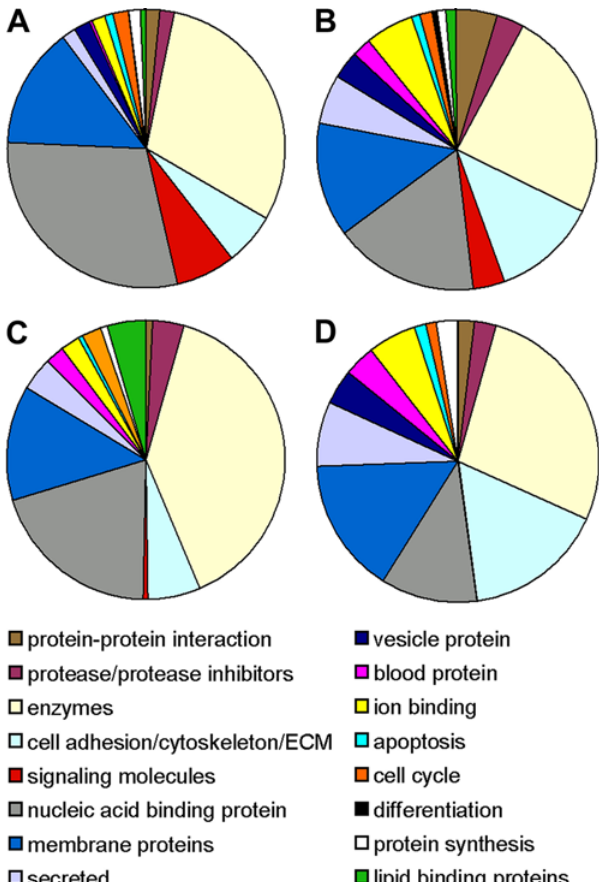
Figure 4. Relative proportion of transcripts altered in Hnf6 Tg animals as determined by gene ontology analysis. Known transcripts altered by 1.5-fold or greater were placed into one of 16 categories, represented by specific colors on each chart. (A) Transcripts up-regulated at e18.5 (total 582). (B) Transcripts down-regulated at e18.5 (total 283). (C) Transcripts up-regulated at P1 (total 135). (D) Transcripts down-regulated at P1 (total 161).